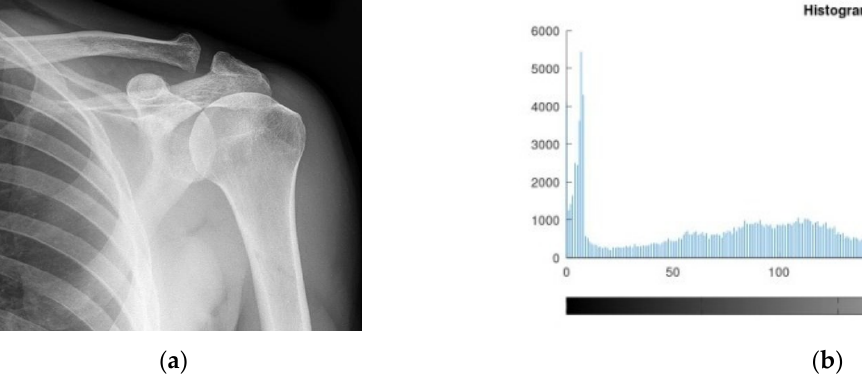
Figure 10. Input image: ( a ) X-ray image and ( b ) histogram.